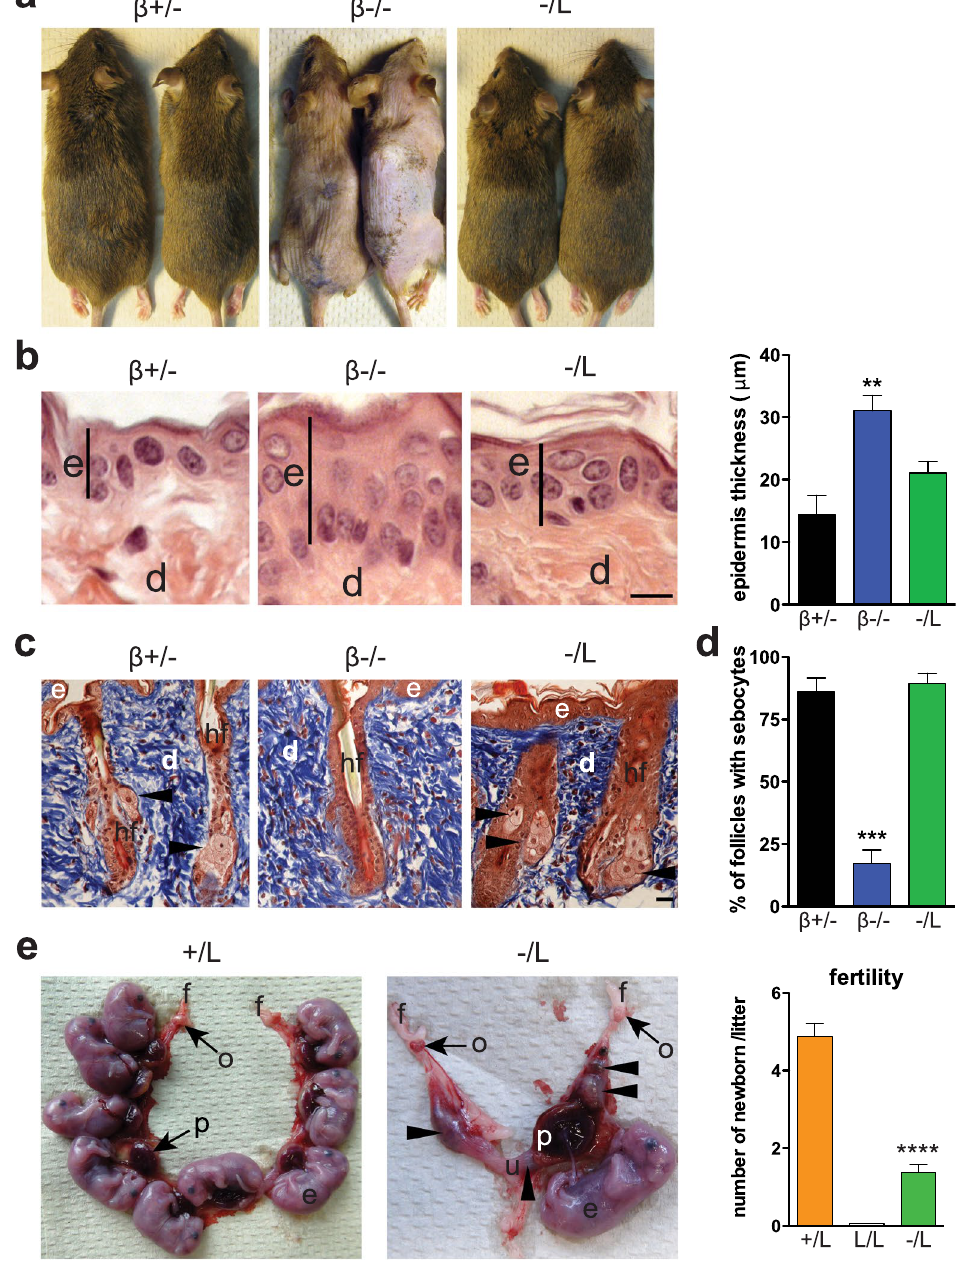
Figure 3. The C/EBP β LIP isoform rescues keratinocyte and sebocyte differentiation and female fertility. ( a ) Representative photograph of the fur of Cebpb male mutant mice. ( b ) H&E staining of dorsal skin showing an increase in epidermal (e) thickness (black line) in β− / − but not in − /L mice. (d) Dermis. Scale bar, 10 μ m. Quantification of epidermal thickness is shown on the right, n = 4–7 per group. ( c ) Trichrome staining of dorsal skin showing hair follicle (hf) lacking sebocytes (arrowhead) in β− / − mice but not in − /L mice. Scale bar, 20 μ m. ( d ) Quantification of the number of hair follicle with sebocytes (%) in Cebpb mutant mice, n = 8–9 per genotype. ( e ) Representative photographs of the uterus of + /L and − /L females at stage E18.5. Note that in − /L uterus most of the embryos (e) are necrotic (arrowhead) except one, which reached full development. Placenta (p), uterus (u), fat (f), and ovary (o). Quantification of the number of newborn per litter (right panel), n = 5–17 per genotype (also see Supplementary Table 1). In all panels, data are presented as mean ± SEM. ** P < 0.01, *** P < 0.001, **** P < 0.0001 by Student’s t -test and the mice were 12 months of age in ( a – d